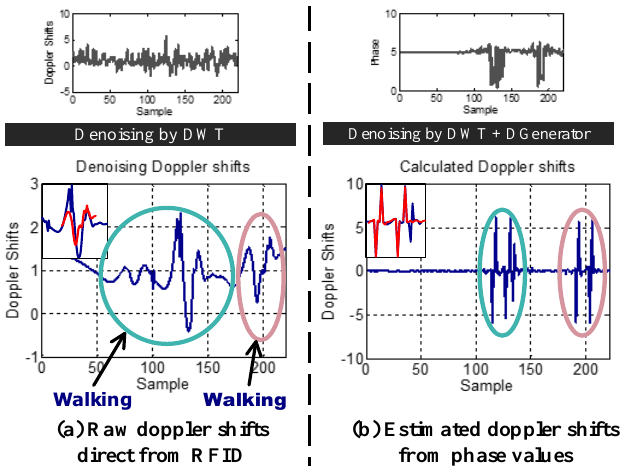
Figure 2. The Doppler shifts we calculated were better than we obtained from the RFID reader